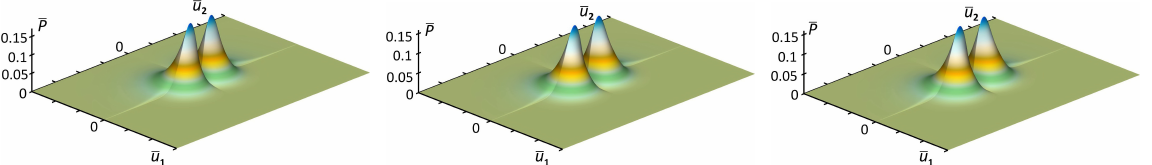
Figure 3. Distributions of free fields of the environment, respectively, at the time points t 1 = 1.5, t 2 = 3, t 3 = 10 and t 4 = 20. The data of the third row table, corresponding to strong elastic and inelastic processes occurring in the environment, were used for the calculation. As can be seen